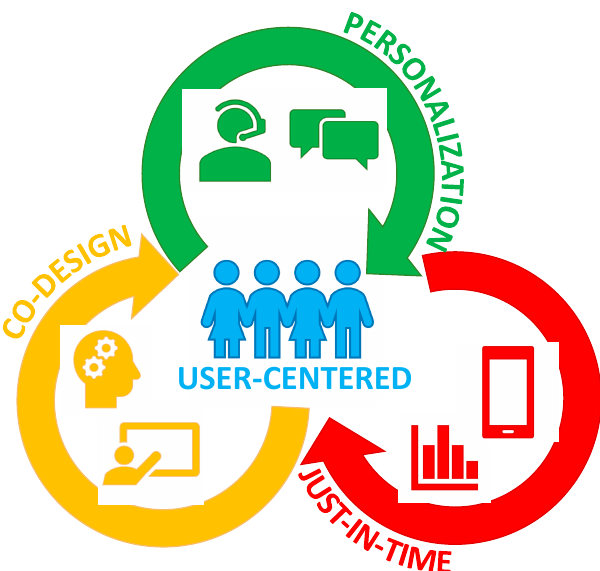
Figure 1. A conceptual illustration of the interaction between the three user-centered strategies, namely, co-design, personalization, and just-in-time adaptation.